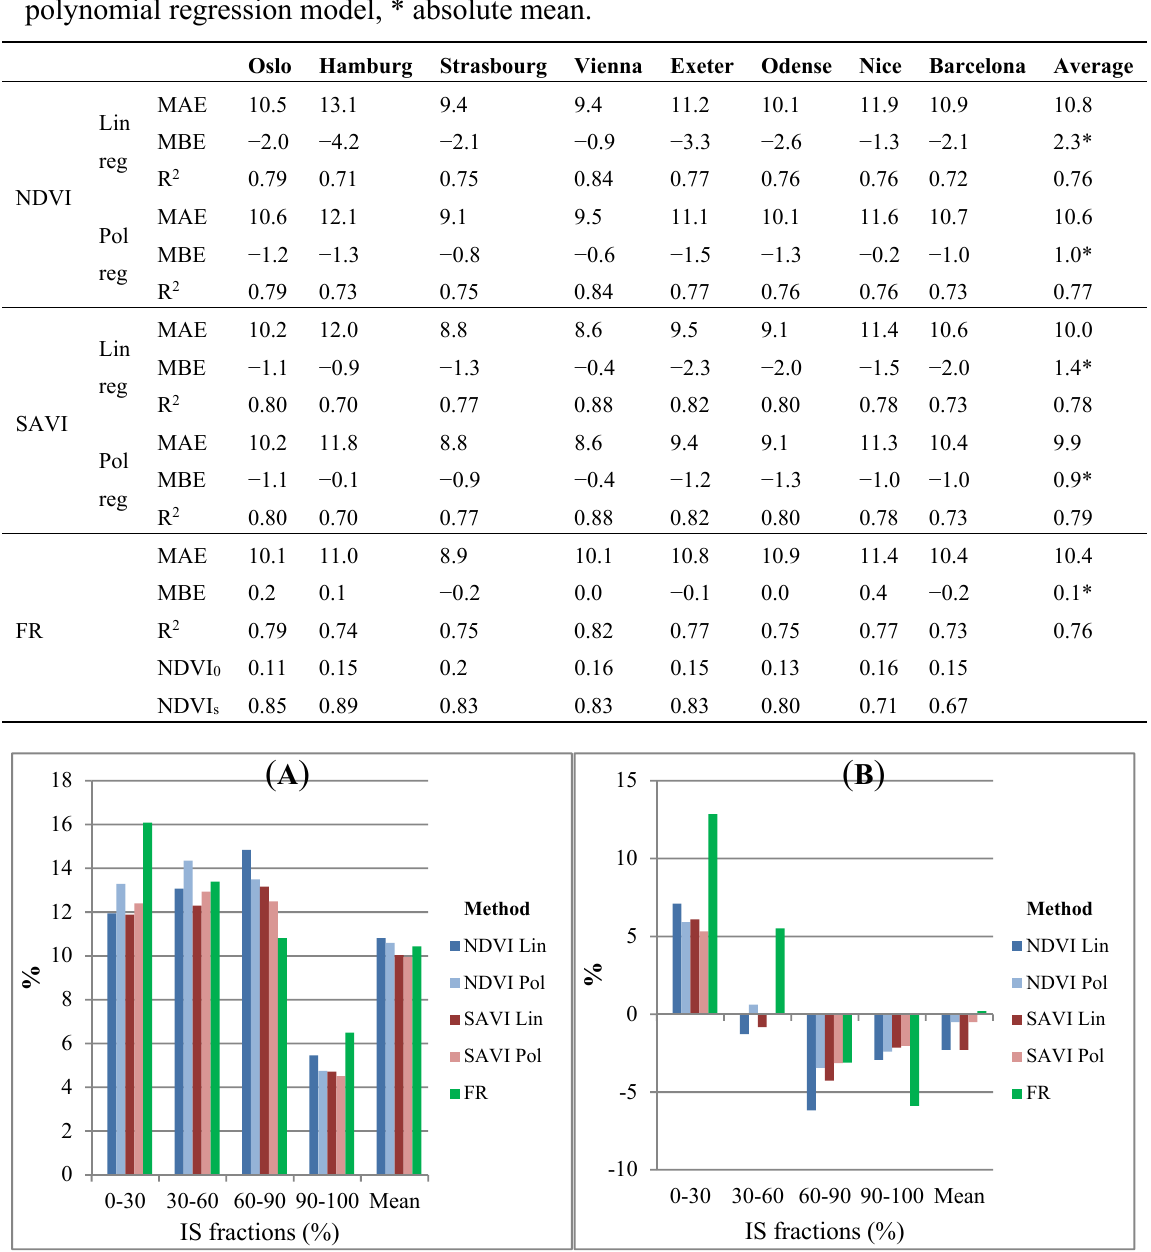
Figure 7. ( A ) Average MAE and ( B ) average MBE for different levels of imperviousness for all the urban sub areas. NDVI Lin = IS fractions from linear regression model, NDVI Pol = IS fractions from second order polynomial regression model, SAVI Lin = IS fractions from Linear regression model, SAVI Pol = IS fractions from Second order polynomial regression model, FR = IS fractions based on